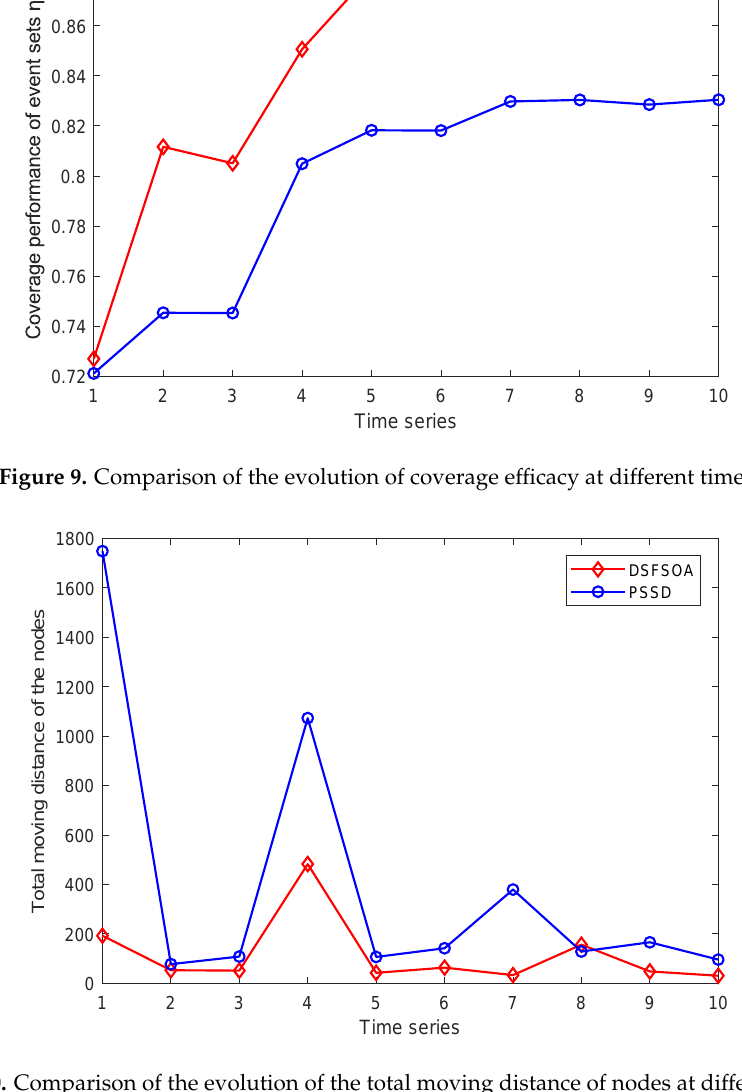
Figure 10. Comparison of the evolution of the total moving distance of nodes at different times.